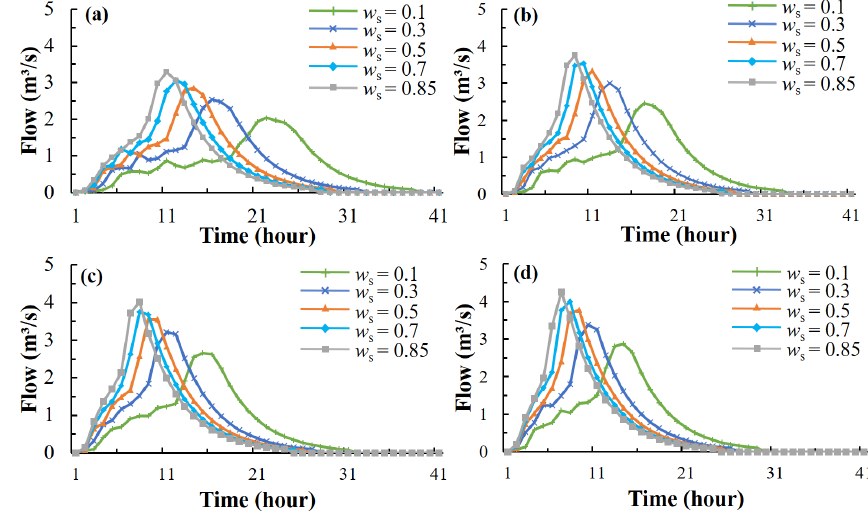
Figure 12. The TDUH considering soil moisture content for the Longhu River basin. (a) I s = 0 . 5. (b) I s = 1. (c) I s = 1 . 5. (d) I s = 2.